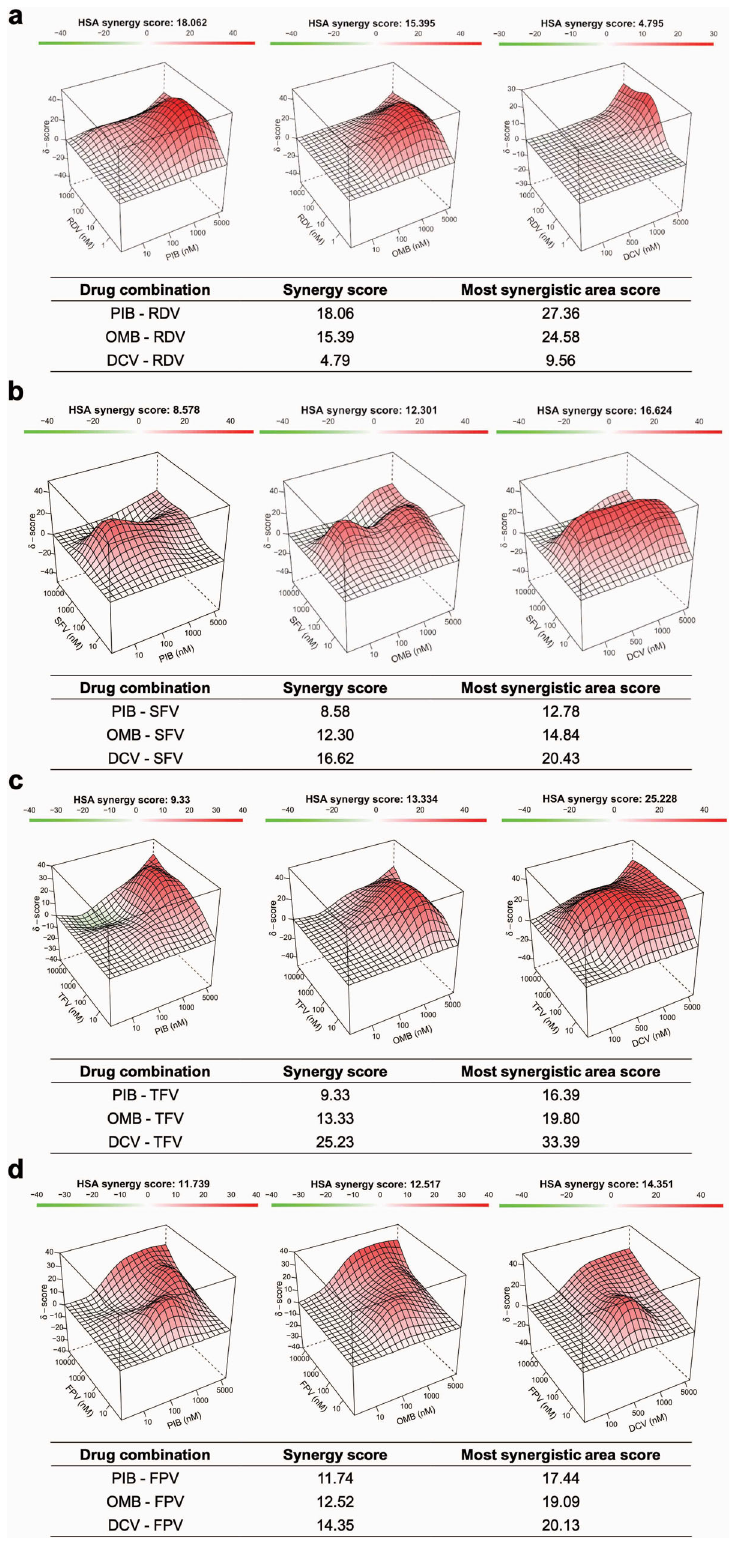
Fig. 8 Synergistic effects of combinations of RdRp and NS5A inhibitors in inhibiting SARS-CoV-2 replication. Calu-3 cells (5 x 10 5 cell/well) were infected with SARS-CoV-2 at a MOI of 0.1. After a 1 h of inoculation period, cells were treated with Remdesivir (RDV) ( a ), Sofosbuvir (SFV) ( b ), Tenofovir (TFV) ( c ), or Favipiravir ( d ) (FPV) with or without Pibrentasvir (PIB), Ombitasvir (OMB), or Daclatasvir (DCV); culture supernatant was harvested 2 – 3 days post-infection and titered in Vero E6 cells by PFU. Results were calculated as the percentage of inhibition and plotted online using SyngergyFinder2.0 (https://synergy fi nder. fi mm. fi /). Scores were determined after applying the highest single agent (HSA) algorithm. Scores are interpreted as follows: synergistic effect >10, additive effect <10 and > − 10, antagonistic effect < −